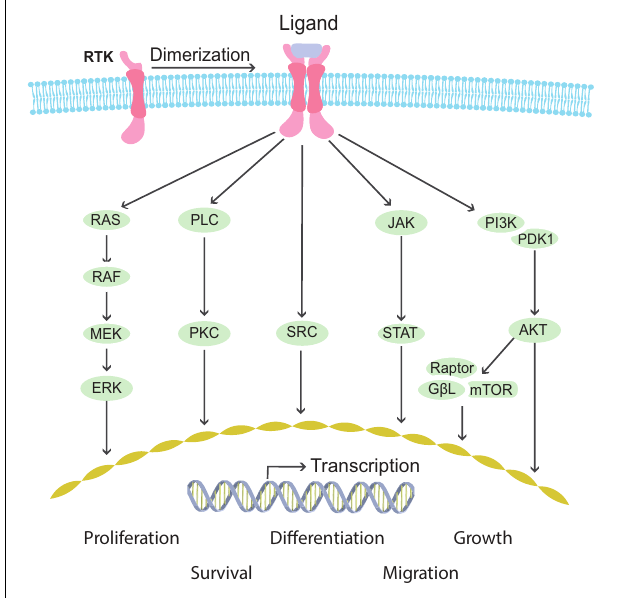
FIGURE 3 | Schematic overview of pathways activated downstream of receptor tyrosine kinase (RTK) signaling. RTK receptors mediate outside signals to the interior of the cell through the cell membrane penetrating domains. Extracellular ligand binding induces receptor dimerization, which activates several intracellular cascades including MAPK, PLC/PKC, SRC, JAK/STAT, and PI3K/AKT. These signaling pathways induce transcriptional responses in the nucleus and changes of protein activities in the cytosol leading to cellular reactions such as proliferation, differentiation, growth, survival, and